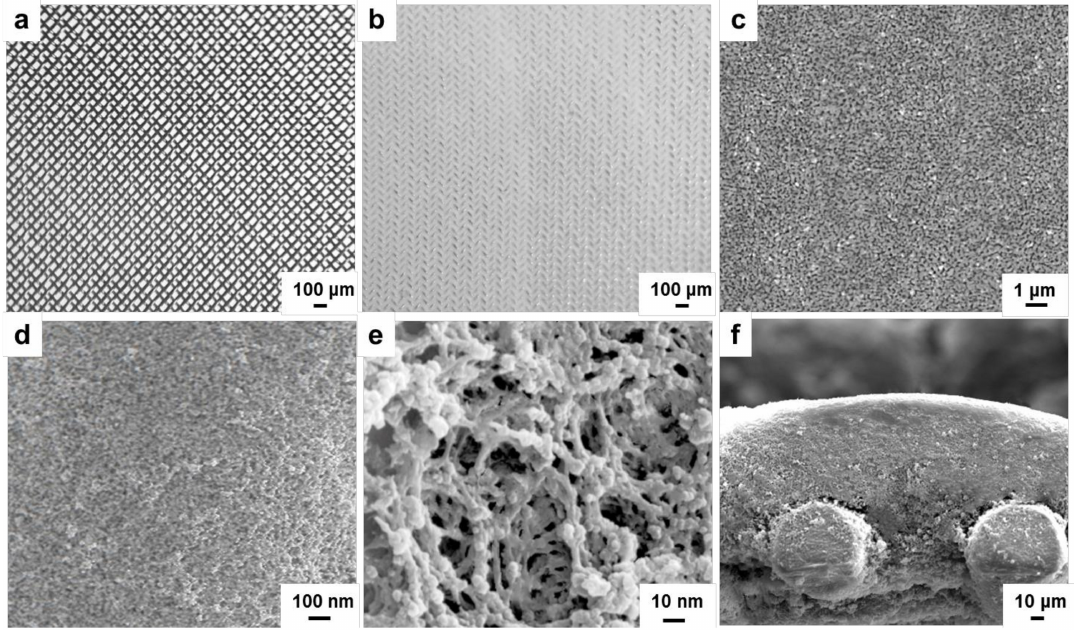
Figure 7. Optical micrographs of stainless steel wire mesh (SSWM) ( a ) and SSWM supported ECB-MICM ( b ). Scanning electron microscopy (SEM) of ECB-MICM ( c – e ) observed at different magnification, and the lateral ( f )